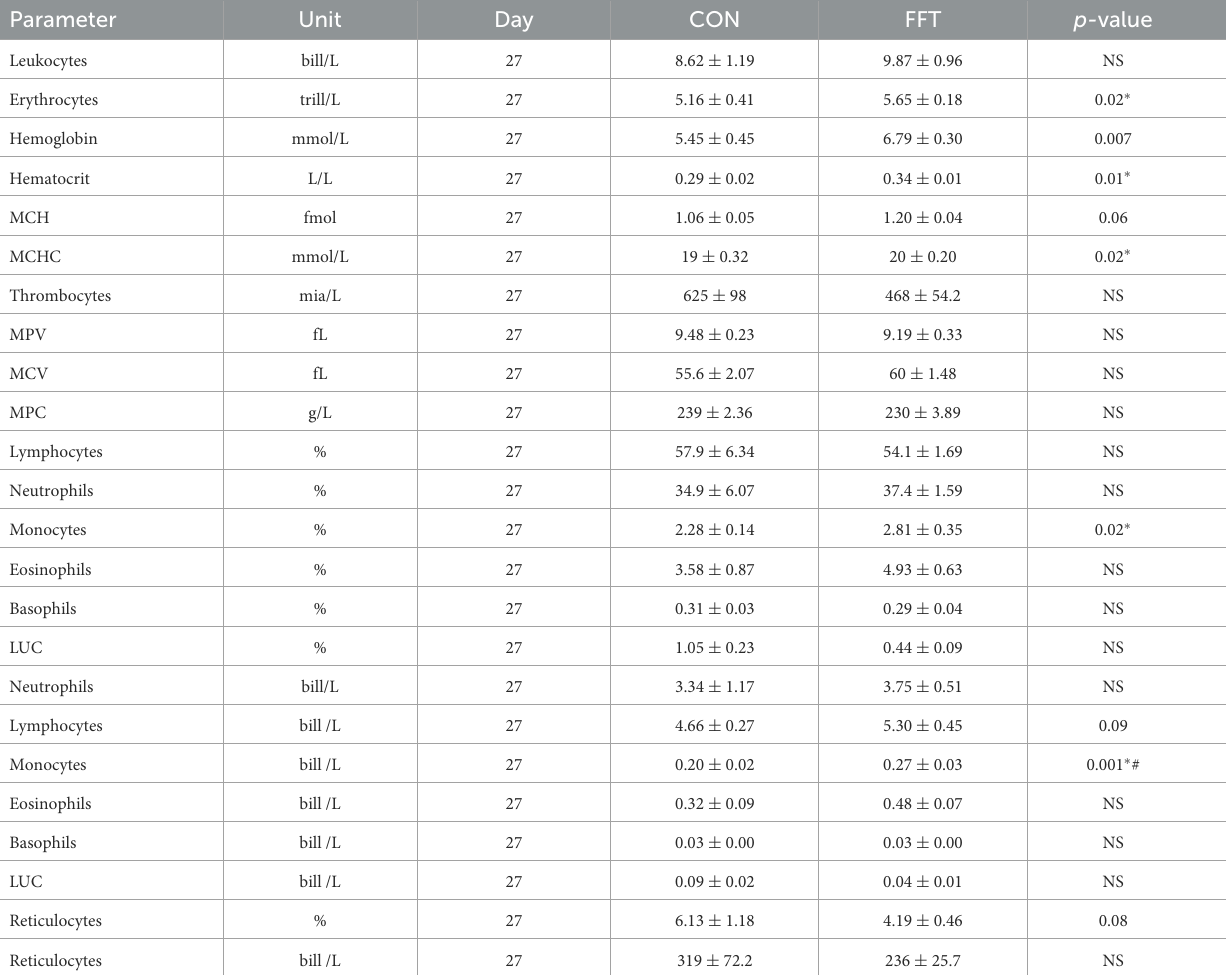
TABLE 6 Hematological parameters of piglets on day 27 ( n = CON: 6; FFT: 7). Parameter Unit Day CON FFT p- value Leukocytes